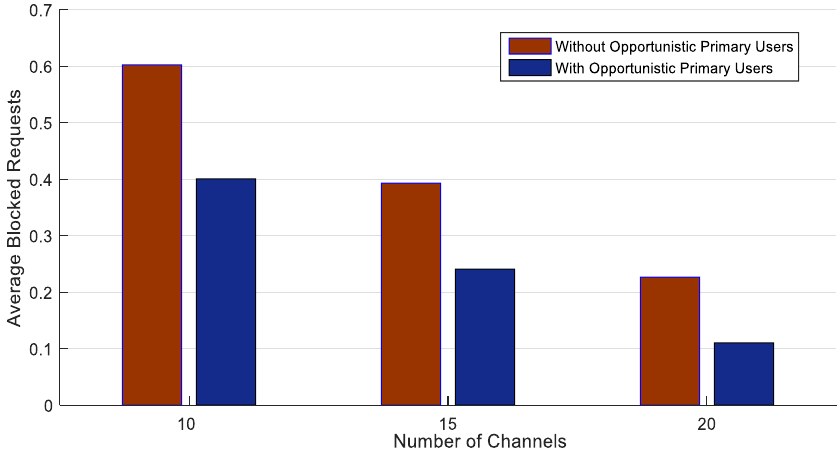
Figure 10. Average blocked requests on the varying number of